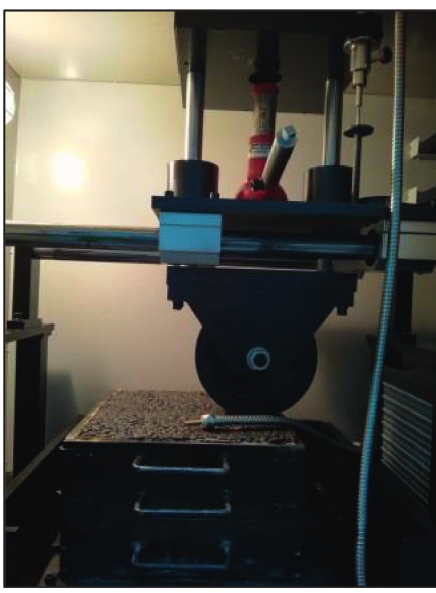
Figure 6: Rutting test